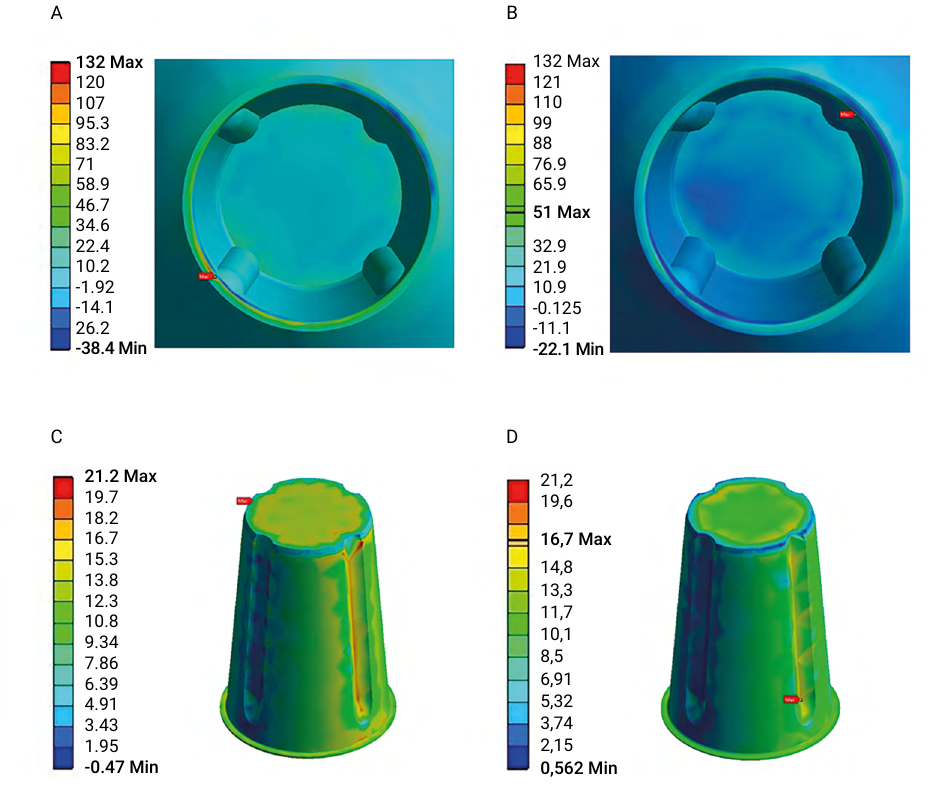
Figure 3. Stress distribution in the crown (σ ) and cement layer (τ ). Cervical view of the crown restored max max with a 65 µm (A) and 38 µm (B) cement layer showing the stress peak on the inner face. Isometric view of the cement layer with 65 µm (C) showing the stress peak on the occlusal face, and 38 µm (D) with the stress peak on the axial